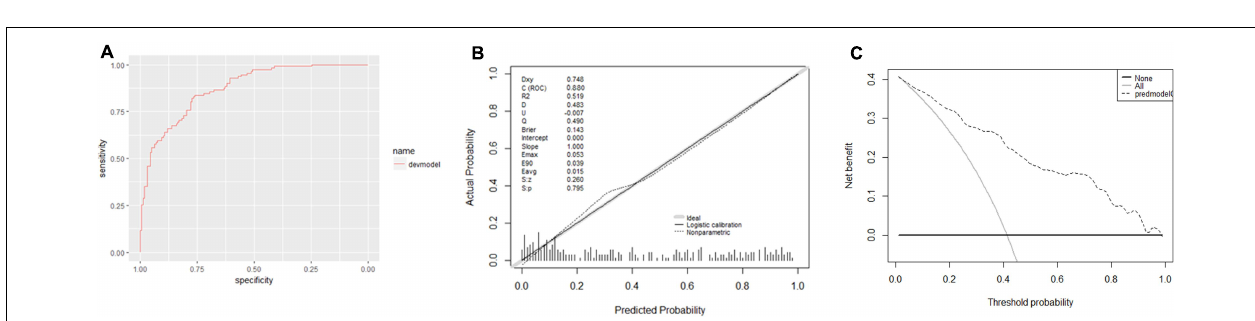
FIGURE 5 | (A) Receiver operator characteristic curve. The AUC was 0.88 in the derivation cohort. (B) Calibration curves. The 45 ◦ shaded line represents the ideal prediction, and the prediction probability is consistent with the actual observation probability. The blue line represents the actual prediction of the model. The stapled histogram on the bottom line represents the distribution of the patients’ predicted probability. Abbreviations: Dxy = Somer’s D rank correlation, R2 = Nagelkerke-Cox-Snell-Maddala-Magee R-squared index, D = Discrimination index, U = Unreliability index, Q = Quality index, Emax = maximum absolute difference in the predicted and calibrated propabilities, S:z = Spiegelhalter Z -test, and S:p = two-tailed p -value of the Spiegelhalter Z -test. (C) Decision analysis curve. The horizontal axis is the threshold probability of the PTB occurrence. The vertical axis shows the clinical benefits that the patients may gain or lose using the web application. Dotted line: prediction model. Solid line: all patients were PTB. Horizontal line: all patients were not PTB.